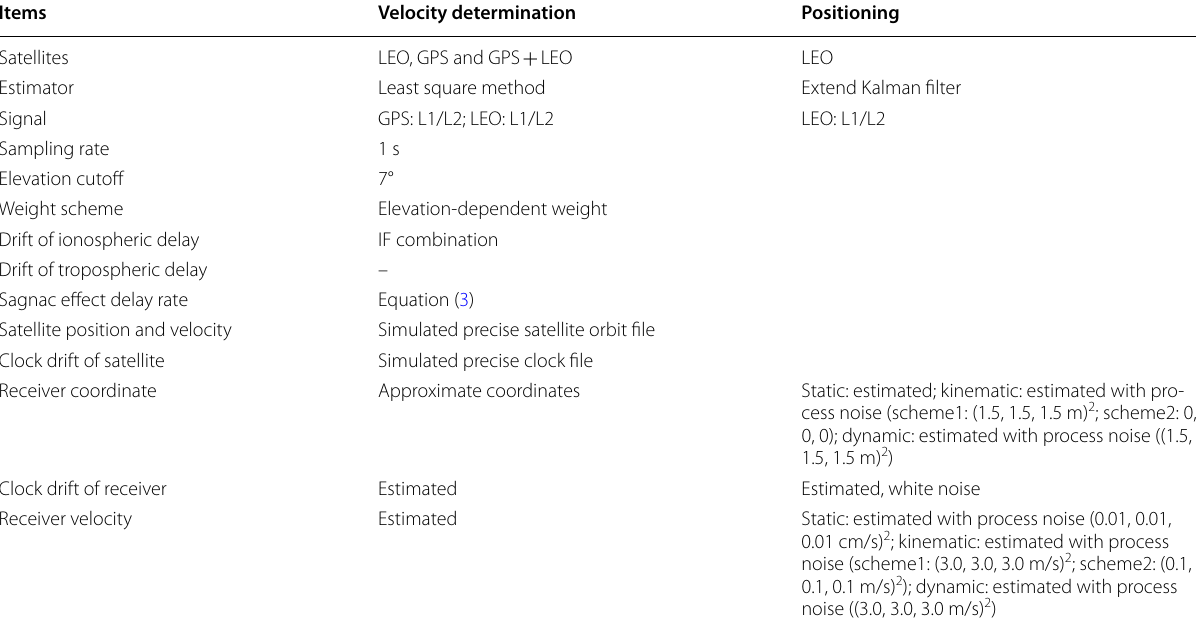
Table 2 Data processing strategy